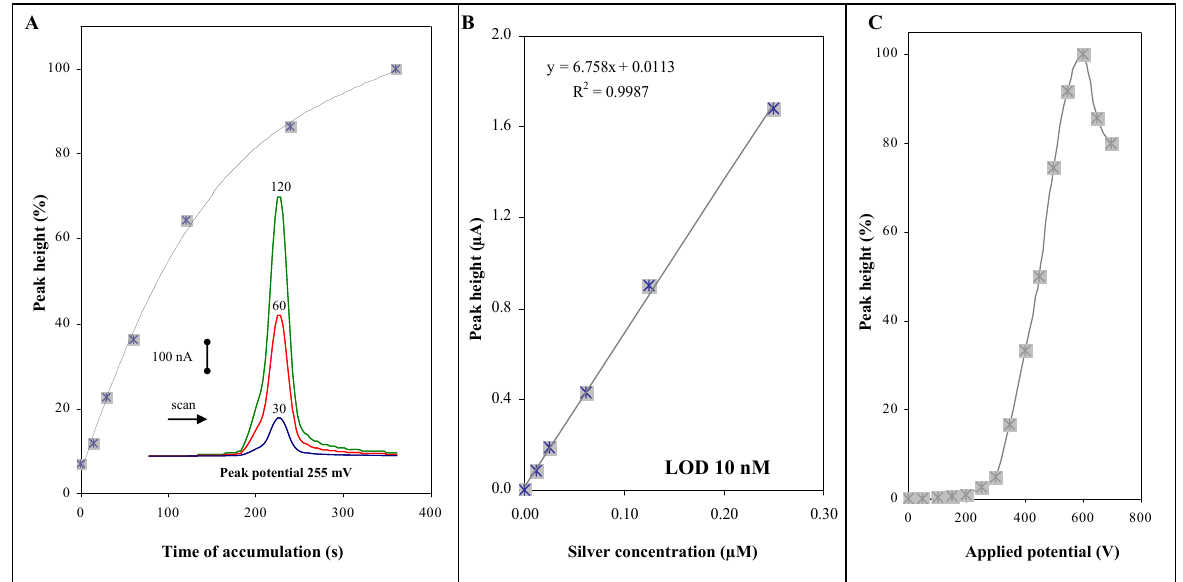
Figure 5. Carbon pencil working electrode. (A) Dependence of peak height of silver(I) ions (1 µM) on the accumulation time measured at 0 V; in inset: DP voltammograms measured at accumulation times 30, 60 and 120 s. (B and inset) Dependences of peak height on silver(I) ions concentration (accumulation time 240 s, accumulation potential 0 V). (C) Hydrodynamic voltammogram of silver(I) ions. Flow rate of 0.2 M acetate buffer (pH 5.0) was 0.5